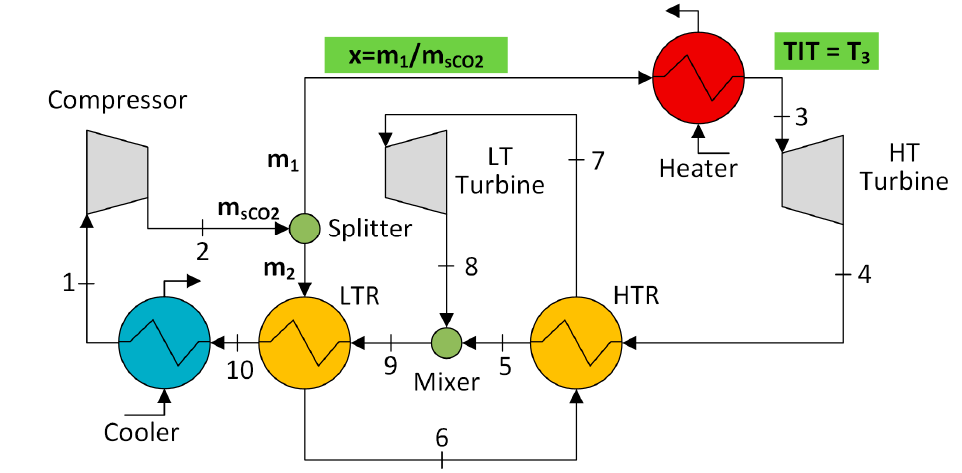
Figure 1. Single flow split with dual expansion s-CO 2 cycle [36].